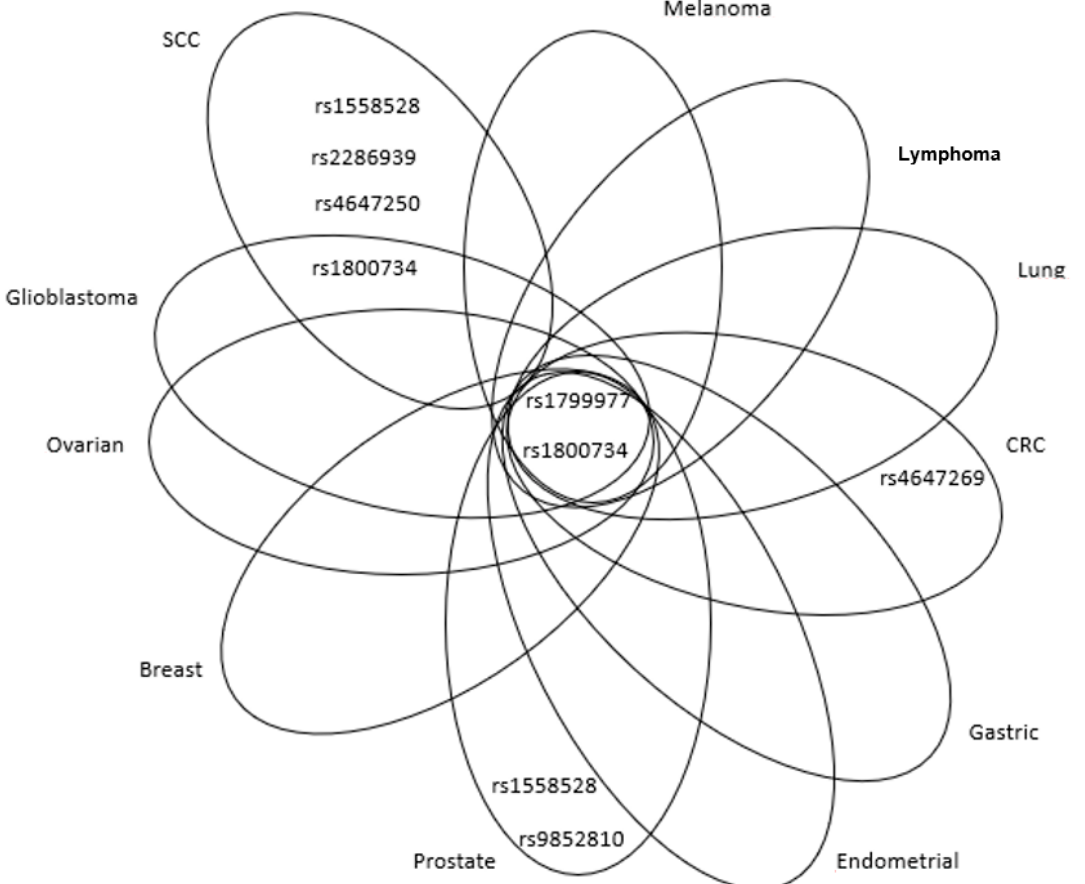
Figure 3. Venn diagram showing relevant MLH1 SNPs, associated with adverse effects, in overlap among different cancer types or peculiar for specific malignancies. SCC: squamous cell carcinoma; CRC: colorectal cancer